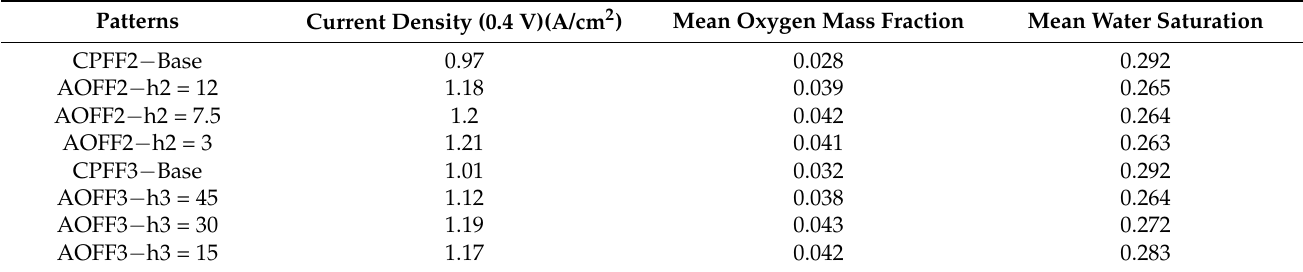
Table 4. The comparison of specific performance parameters .